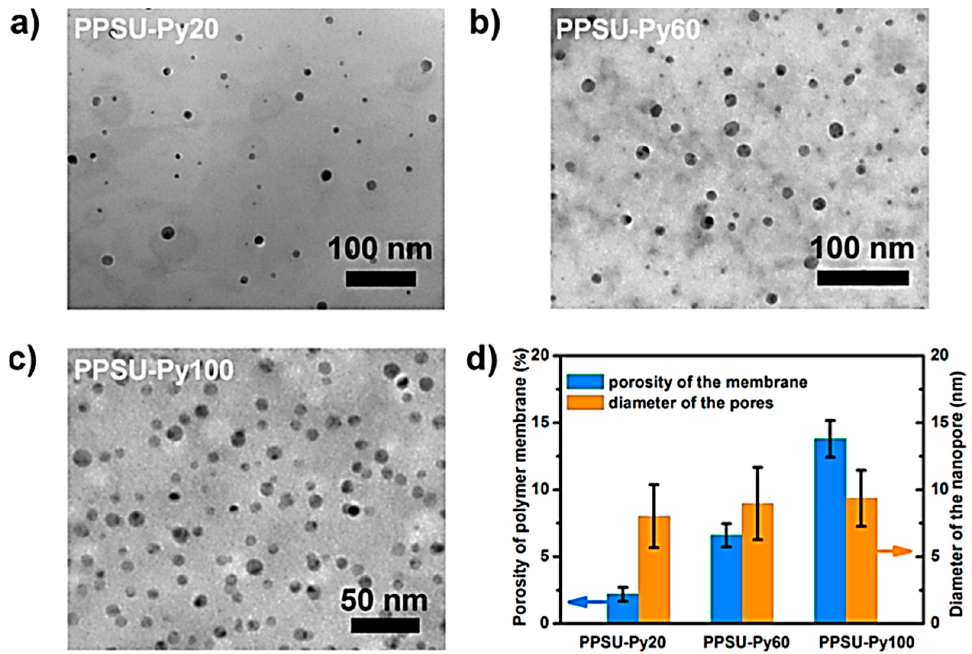
Figure 8. Pore structure and size distribution with different pyridine moiety proportions in PPSU-Pyx. ( a – c ) Transmission electron microscopy images of PPSU-Pyx. Dark areas refer to pores and white areas represent hydrophobic backbone along the copolymer chain. The polymer is marked with PTA, which reacted with pyridine moiety. ( d ) Porosity and diameter of copolymer membrane with different pyridine moiety proportions, indicating improved porosity while pore size stays almost the same [108]. PTA = phosphotungstic acid; PPSU-Pyx = polyphenylsulfone-pyridine; GO = graphene oxide. Reproduced with permission from ACS.